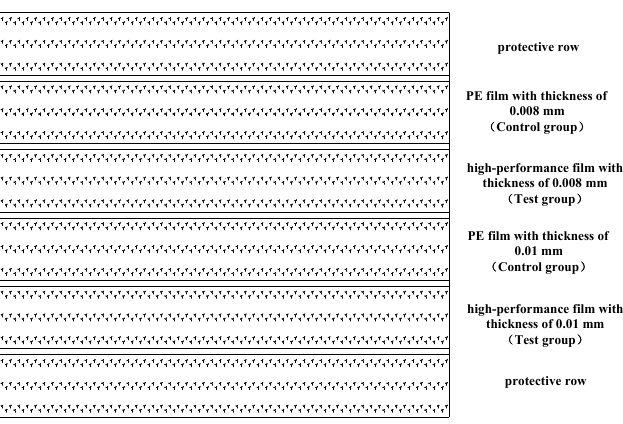
Figure 1. Diagram of plastic film laying in test field.